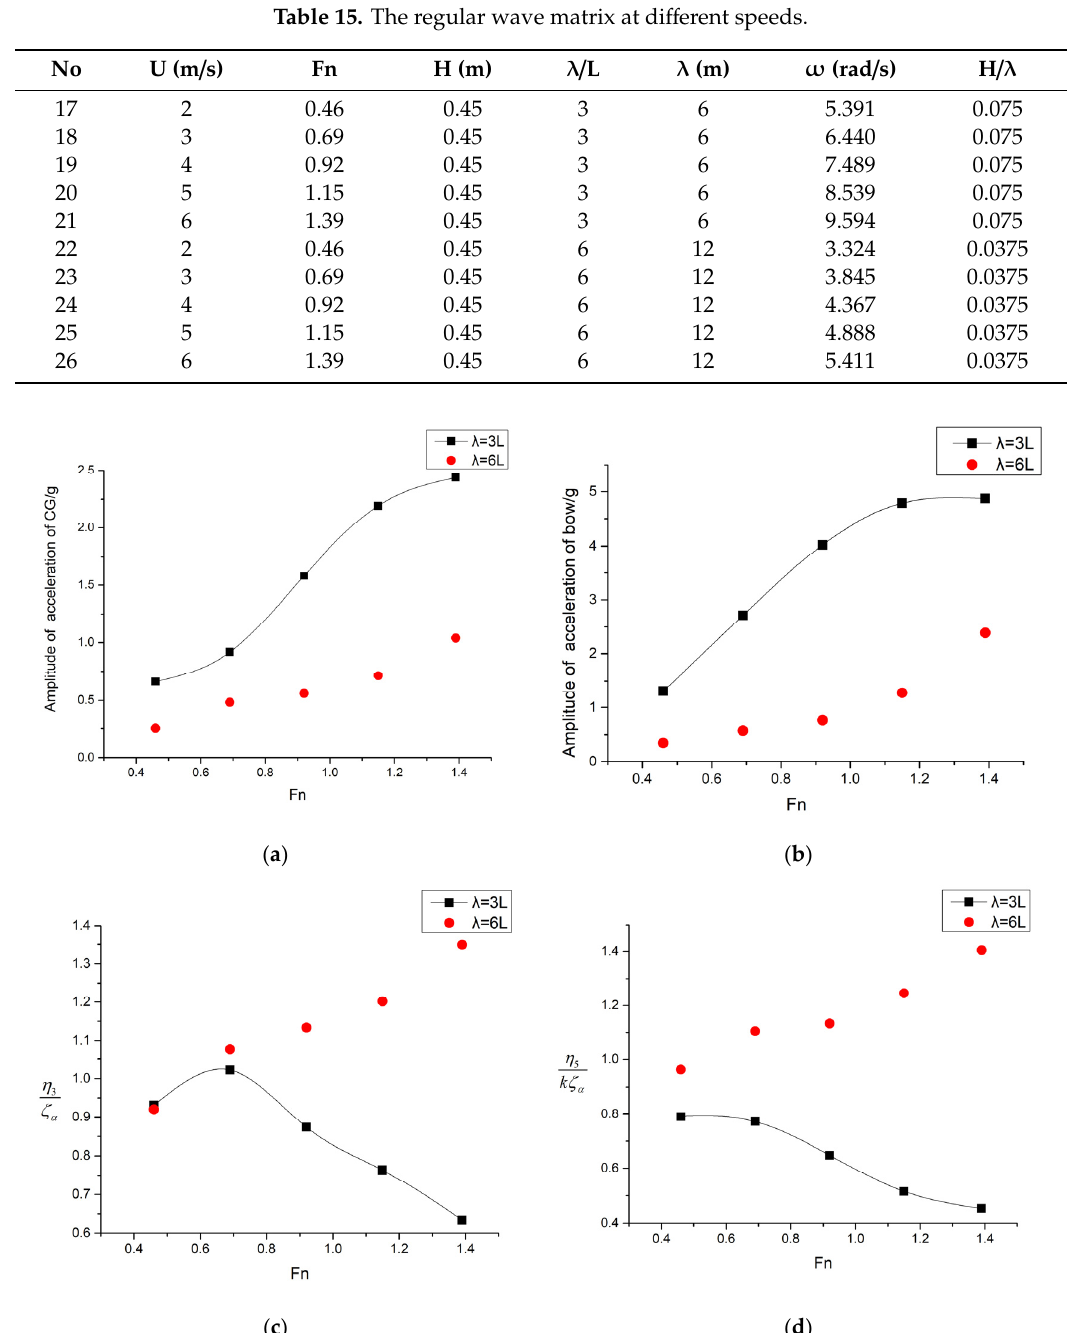
Table 15. The regular wave matrix at di ff erent speeds.